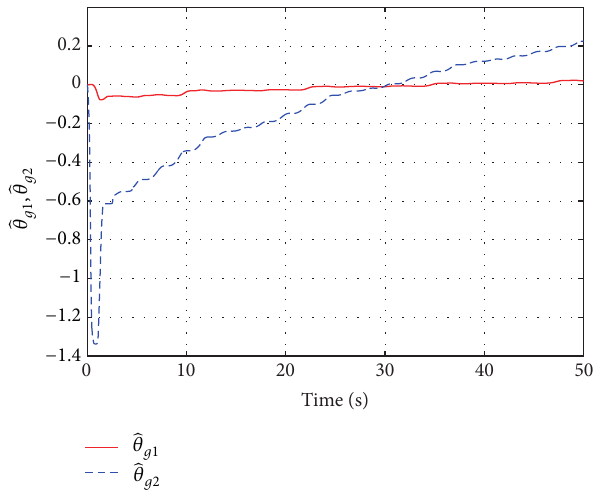
̂𝜃 𝑔 1 (real line) and